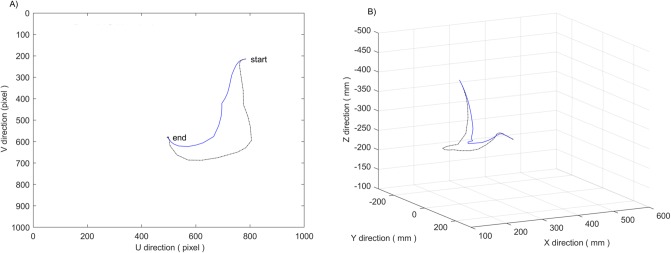
Results of introducing gravitational field.(A) Motion trajectory in image space. (B) Motion trajectory in Cartesian space. Where the simulation result of potential field method is designated with a blue solid line, and the simulation result of image moment method is designated with a black dash-dotted line.